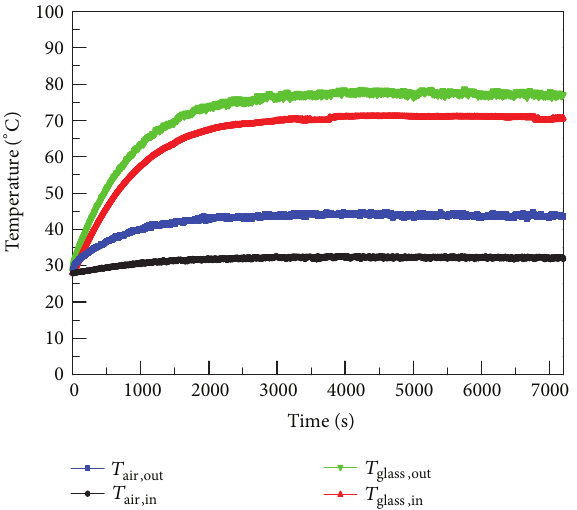
Figure 8: Histories of the surface temperature ( 𝑇 and ambient temperature ( 𝑇 module.